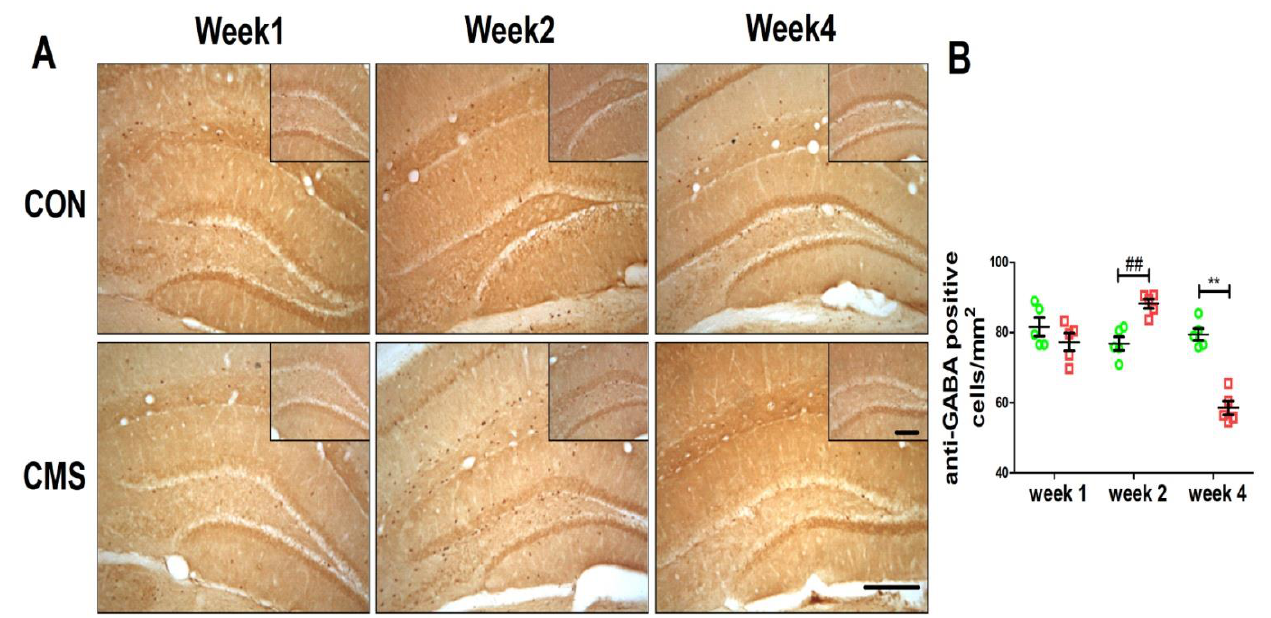
Figure 2. The upregulation of GABAergic neurons in the hippocampus by a moderate duration of stress. ( A ) Anti-GABA immunohistochemical staining of hippocampal tissue of 3-month-old mice. The dark brown dots were considered as anti-GABA-positive GABAergic neurons. ( B ) Quantitative analysis: anti-GABA-positive cells per square millimeter. The numbers of mice were N = 5 per group and the numbers of sections used N = 5 per mouse; the data were expressed as mean ± SEM. ** p < 0.01, 4-week CMS vs. 4-week CON; ## p < 0.01, 2-week CMS vs. 2-week CON. Scale bars are 200 um.